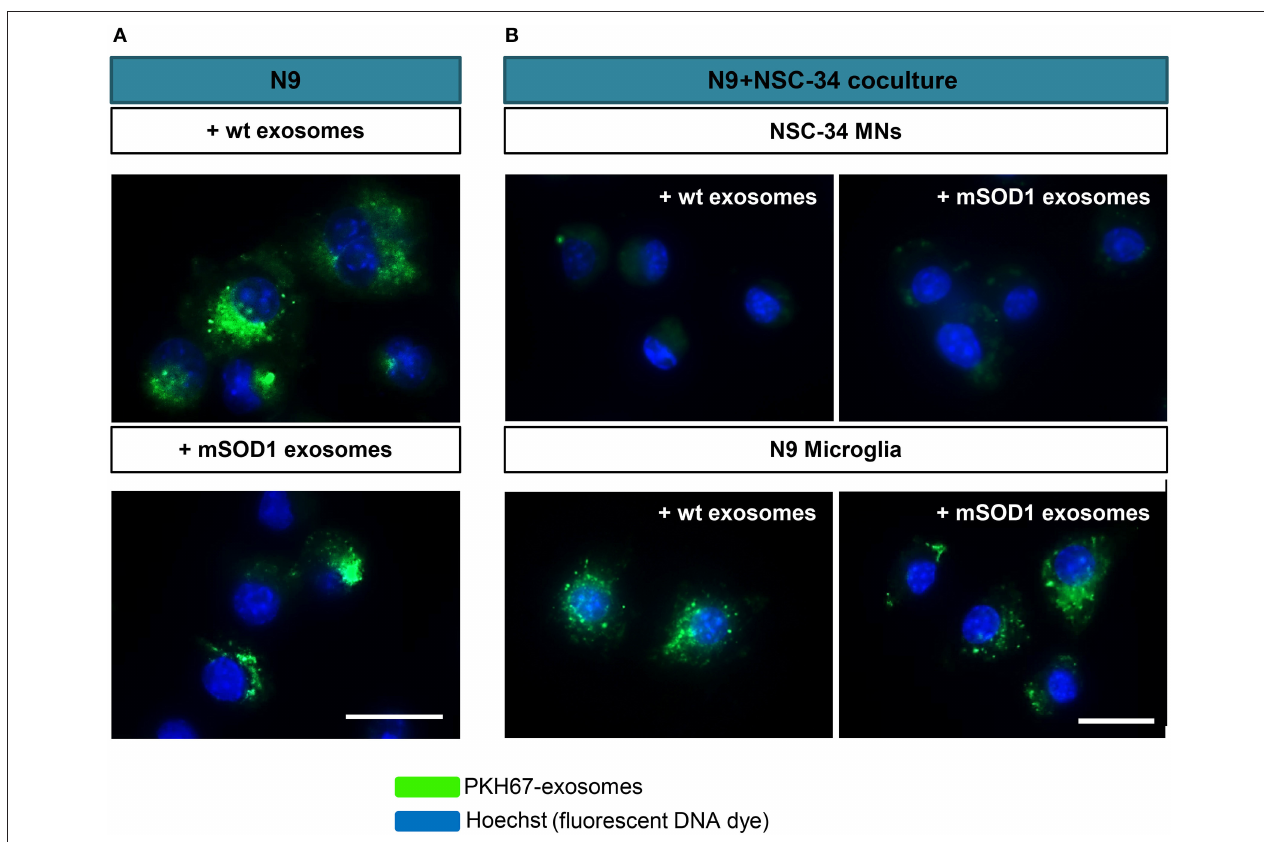
FIGURE 2 | Exosomes from NSC-34 motor neurons (MNs), either wild-type (wt) or mutated in G93A (mSOD1) are equally distributed in N9 microglia, which also revealed to be the preferential recipient cells for exosomes derived from MNs + N9 cocultures. (A) Exosomes were isolated from NSC-34 MNs (wt and mSOD1), stained with the PKH67 Fluorescent Cell Linker Kit (in green) and incubated with N9 microglial cells for 24 h, and representative results of one experiment show the distribution of NSC-34-derived exosomes in monocultured N9 cells. (B) In parallel studies, exosomes were isolated from NSC-34 and N9 cells cocultures, stained as before and incubated for 24 h in a fresh NSC-34+N9 coculture and representative results of one experiment indicate the preferential distribution of exosomes in N9 microglia, as compared with NSC-34 MNs, when in the coculture system. Nuclei were stained with Hoechst dye (in blue). Scale bar represents 20 µ